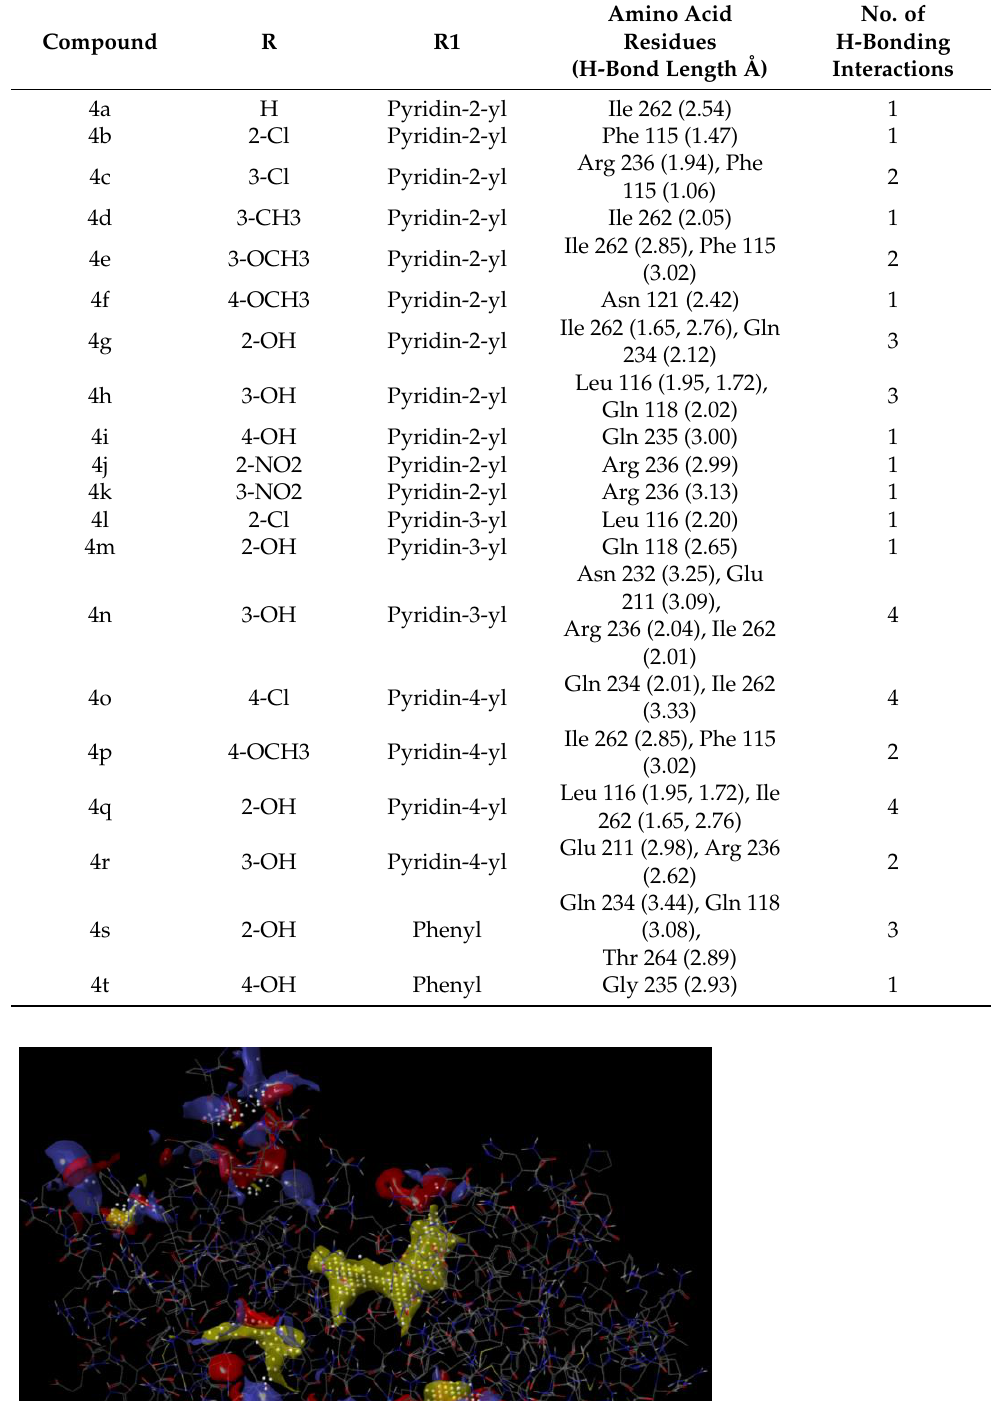
Table 2. H-bonding interactions of compounds 4(a–t) with the protein residues.